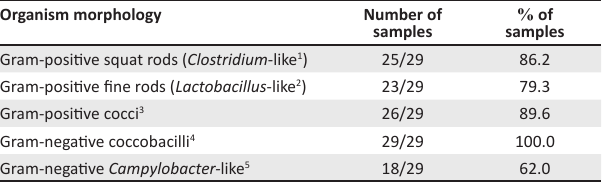
There were no lesions, either macroscopic or microscopic, TABLE 1: Microscopic morphology of bacteria observed in smears of ileal scrap-